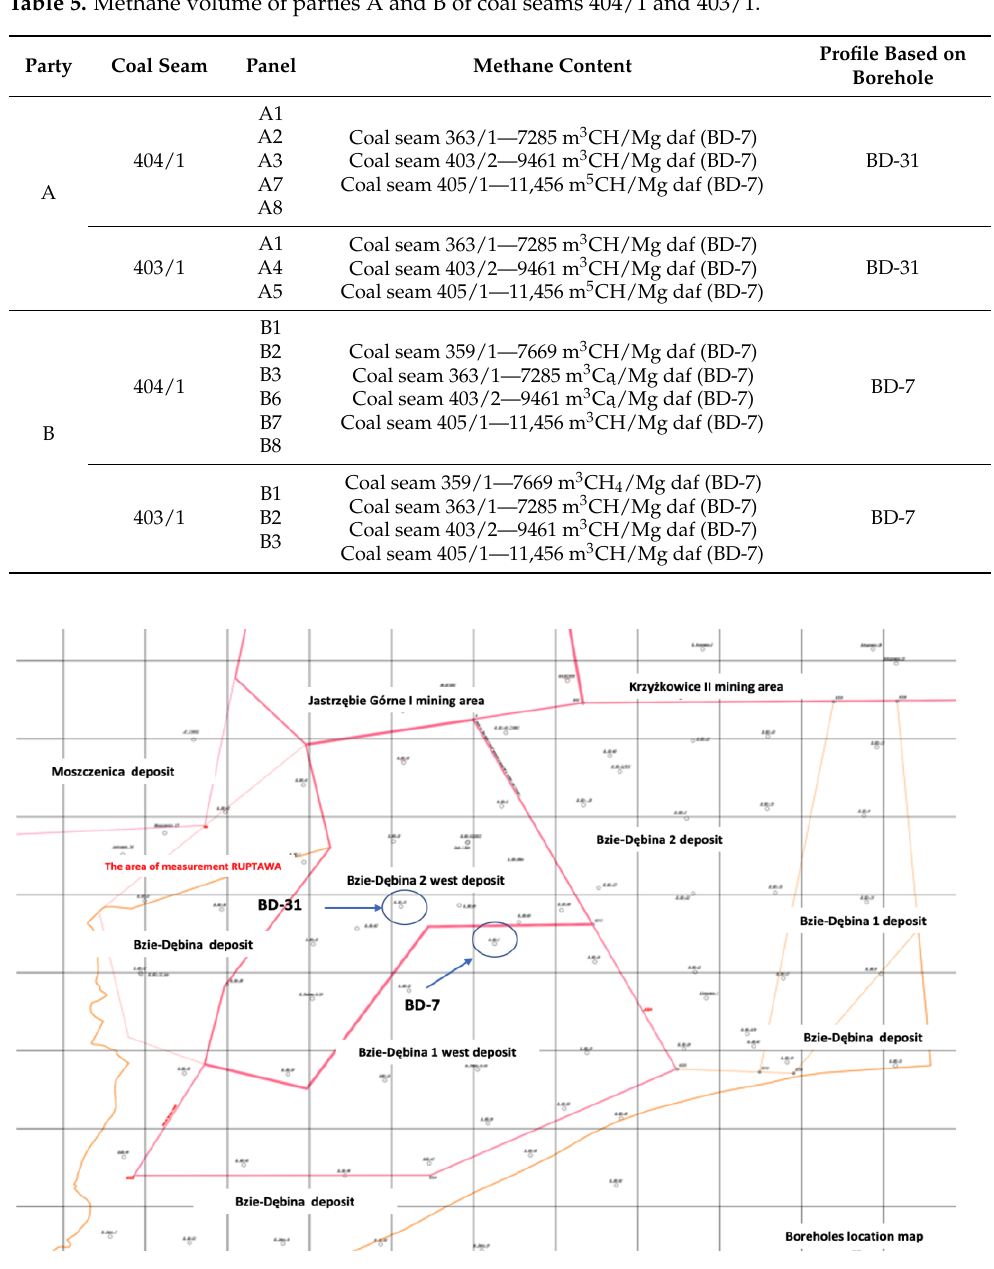
Table 5. Methane volume of parties A and B of coal seams 404/1 and 403/1.